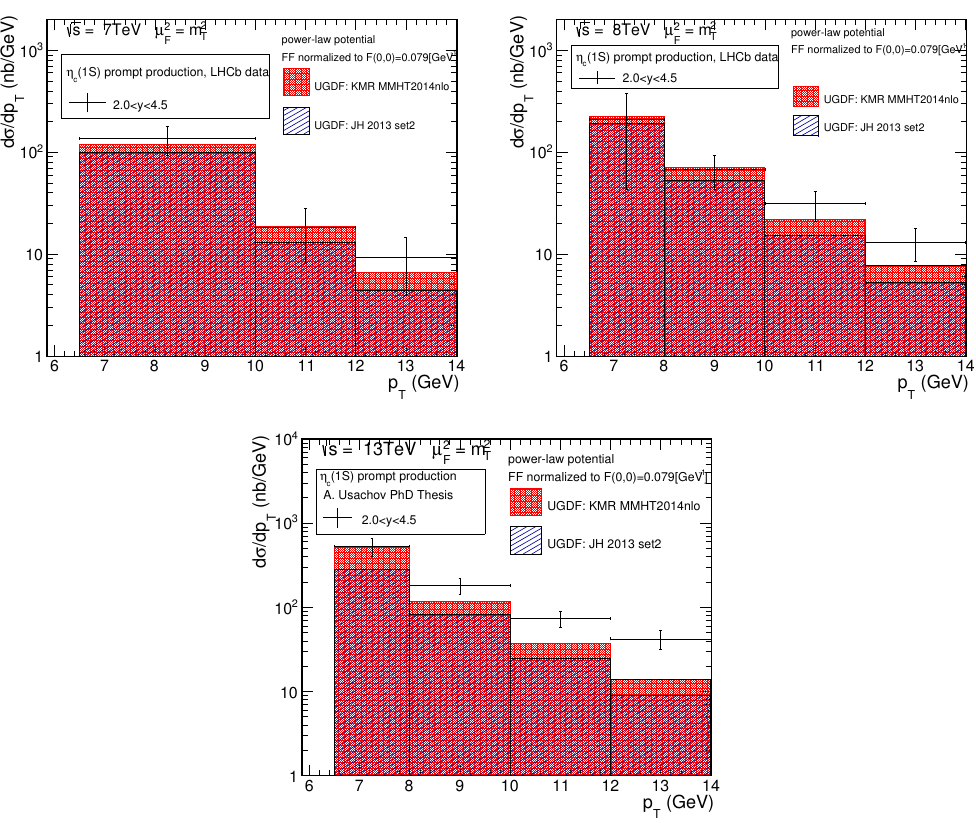
Figure 6 . Prompt production di(cid:11)erential cross section for (cid:17) c (1S) compared with the LHCb data [13] p for s = 7 ; 8 TeV and preliminary experimental data [14] for